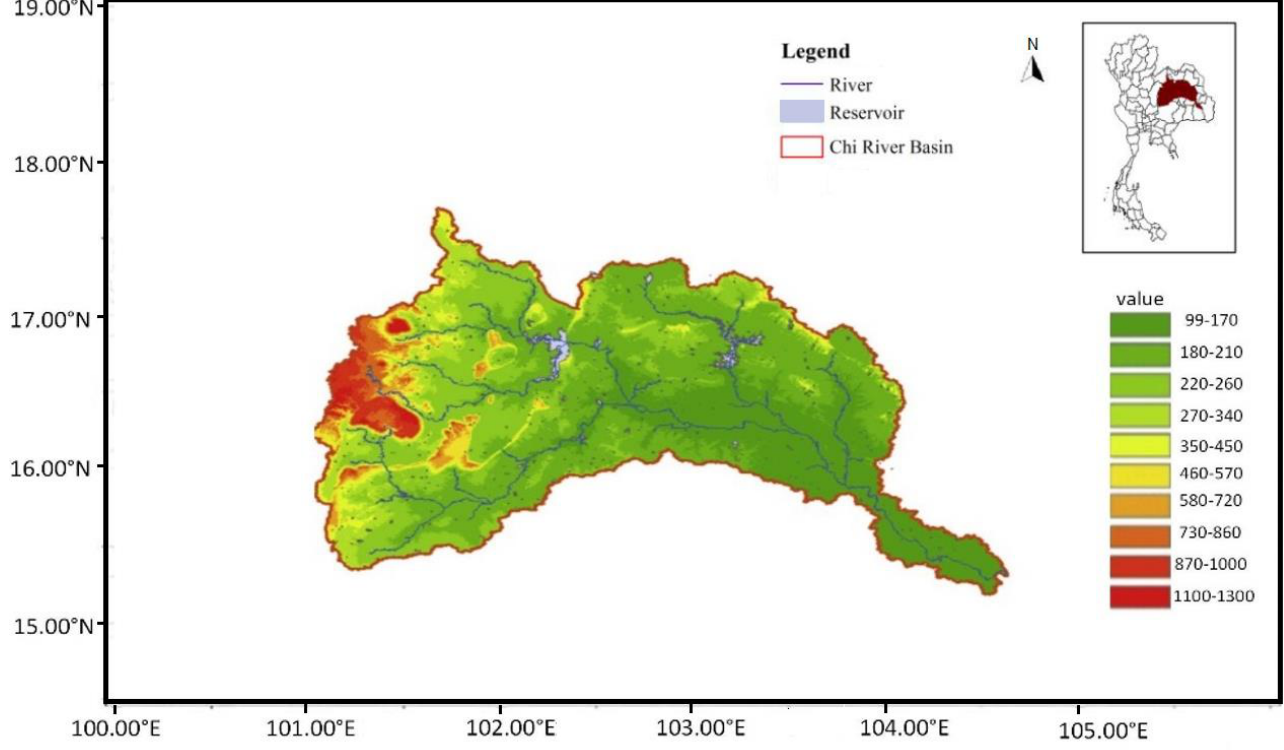
Figure 1. Chi River Basin, including its major rivers, is located in north-eastern Thailand. An inset map of Thailand shows the location of the Chi Basin within Thailand.